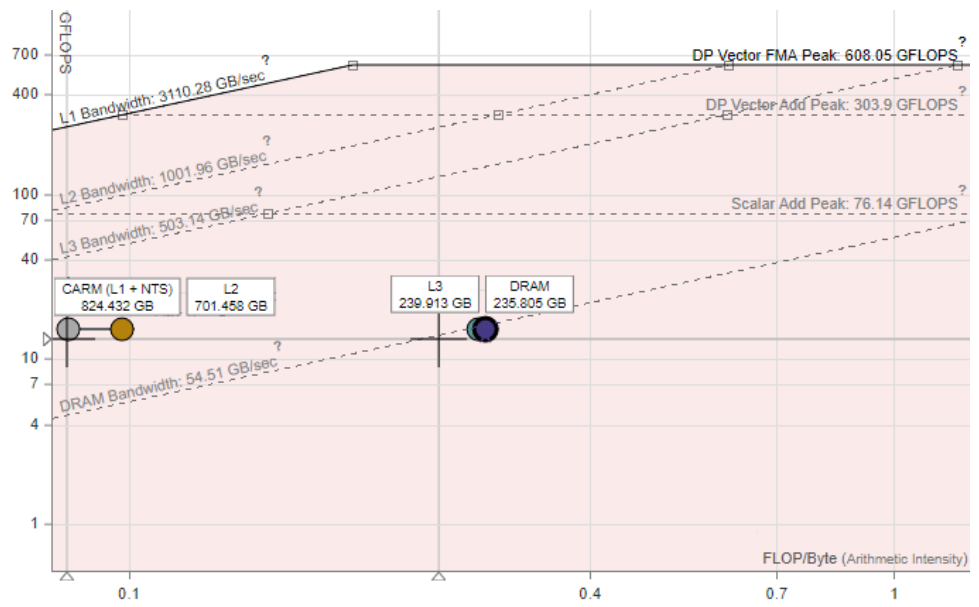
Figure 3. Roofline analysis for implementation of the right-hand parts computation